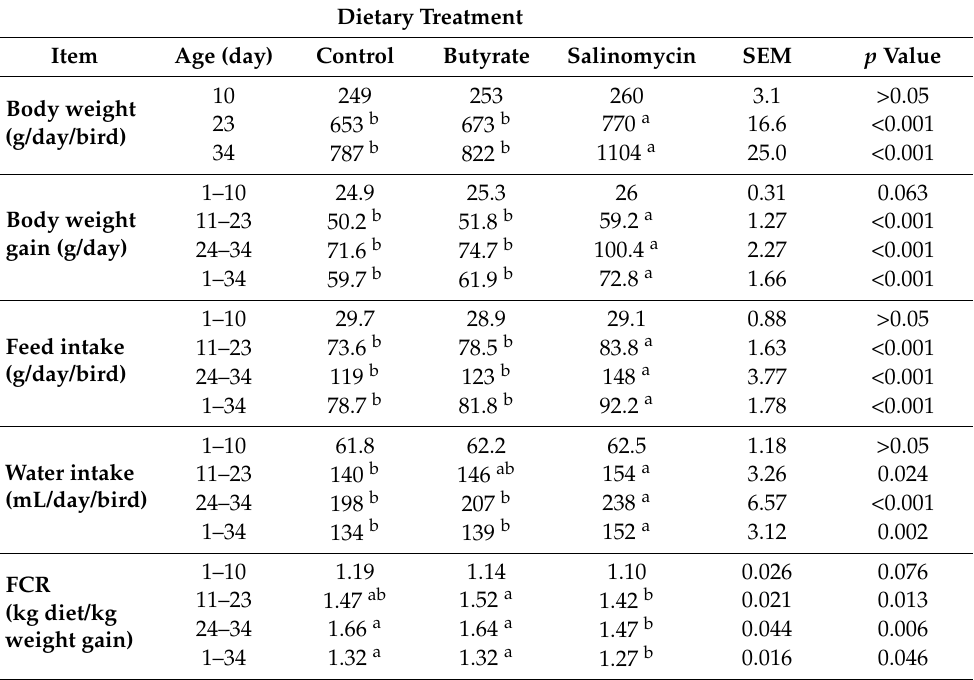
Table 1. Effect of dietary treatments on body weight, body weight gain, feed intake, water